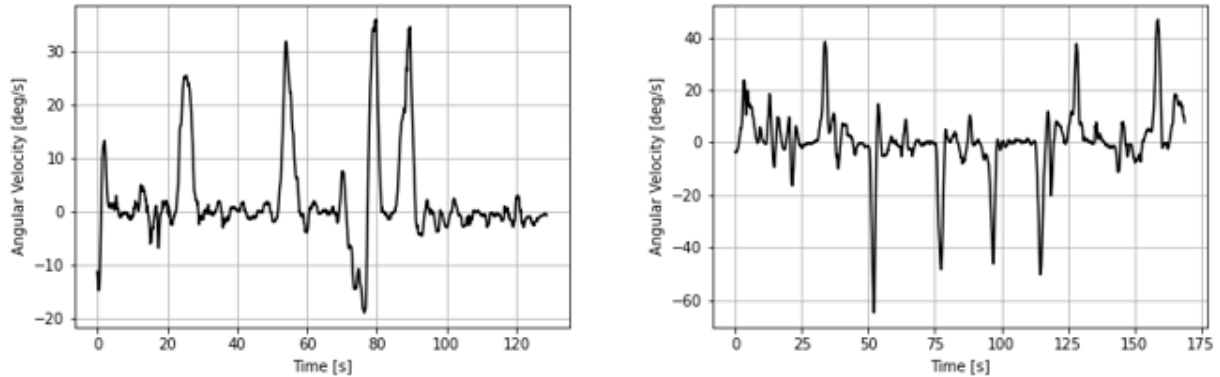
Figure A3. The variations in the vehicle’s angular velocity in the sharp cornering and successive left and right turn scenario.